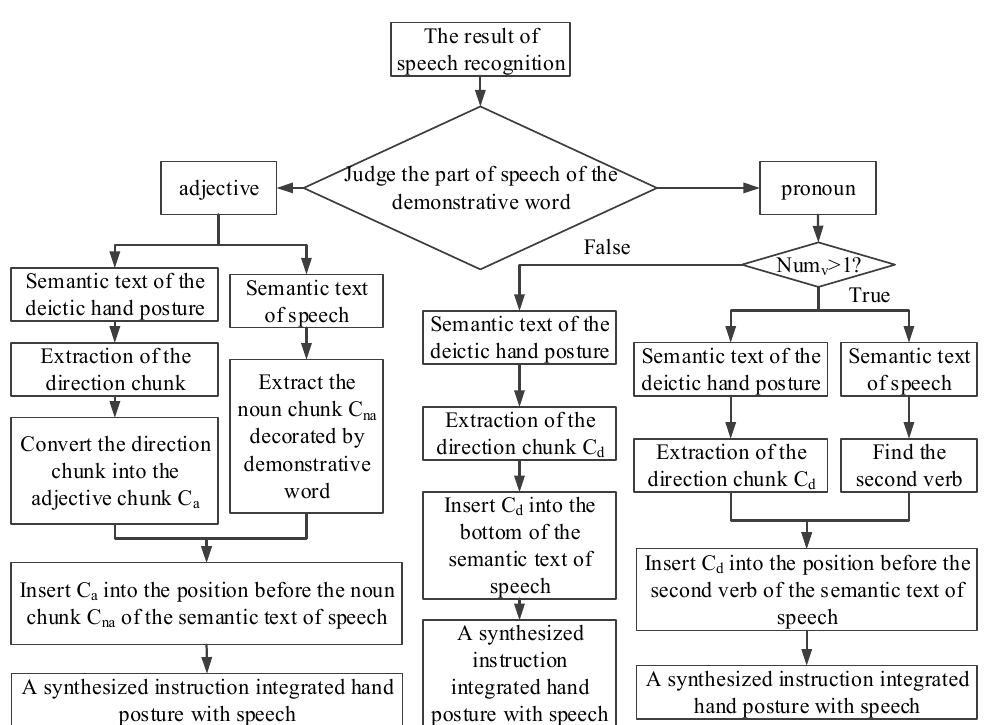
Figure 8. Flowchart for the integration of hand postures and speech based on semantic